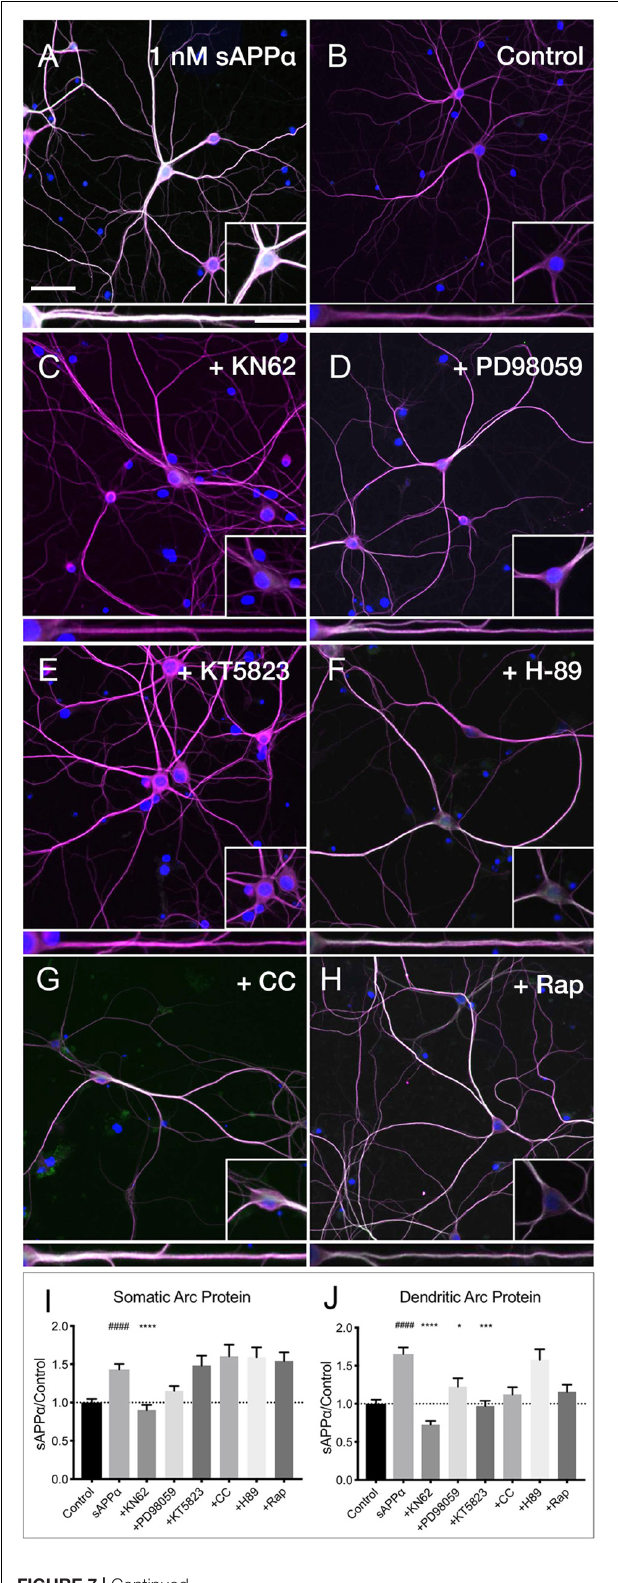
FIGURE 7 | Arc protein expression in response to sAPP α is affected by kinase inhibitors. Representative images showing (A) sAPP α (1 nM, 2 h, n = 125) promotes an increase in the expression of Arc protein in cultured neurons relative to (B) no drug controls ( n = 134). Cells were simultaneously treated with (C) KN62 ( n = 51), (D) PD98059 ( n = 51), and (E) KT5823 ( n = 42), (F) H-89 dihydrochloride ( n = 40), (G) Chelerythrine chloride ( n = 30), or (H) Rapamycin ( n = 40) and Arc levels in the (I) somata and (J) dendrites was measured. Data are expressed as mean ± SEM from ≥ 3 experiments. Significance was calculated using a Kruskal–Wallis one-way ANOVA with Dunn’s multiple comparisons test. Hashes (#) indicate significance between control and sAPP α -treated; asterisks ( ∗ ) indicate significance between sAPP α - and inhibitor-treated; #### p ≤ 0.0001, ∗ p = 0.0428, ∗∗∗ p = 0.0001, ∗∗∗∗ p ≤ 0.0001. Representative images show neurons (magenta), Arc protein (green), DAPI (blue) (scale bar = 50 m), and magnified somatic (inset, bottom right) and dendritic (100 µ m; lower panels; scale bar = 10 µ m)